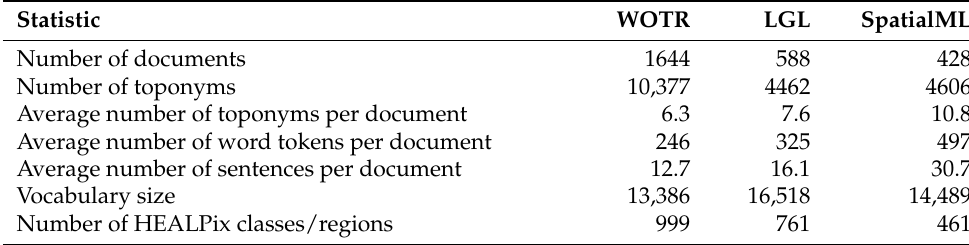
Table 1. Statistical characterization for the different corpora used in the